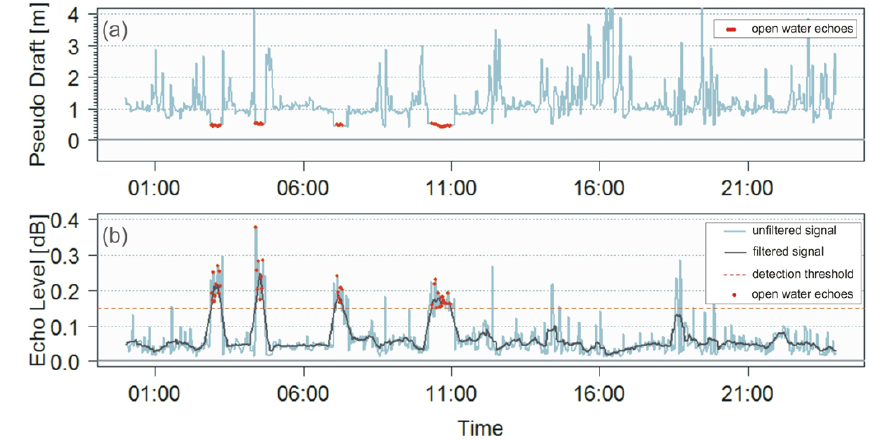
Figure 6. (a) Pseudo draft of AWI 231-7 on 8 November 2007. (b) Echo level of the same